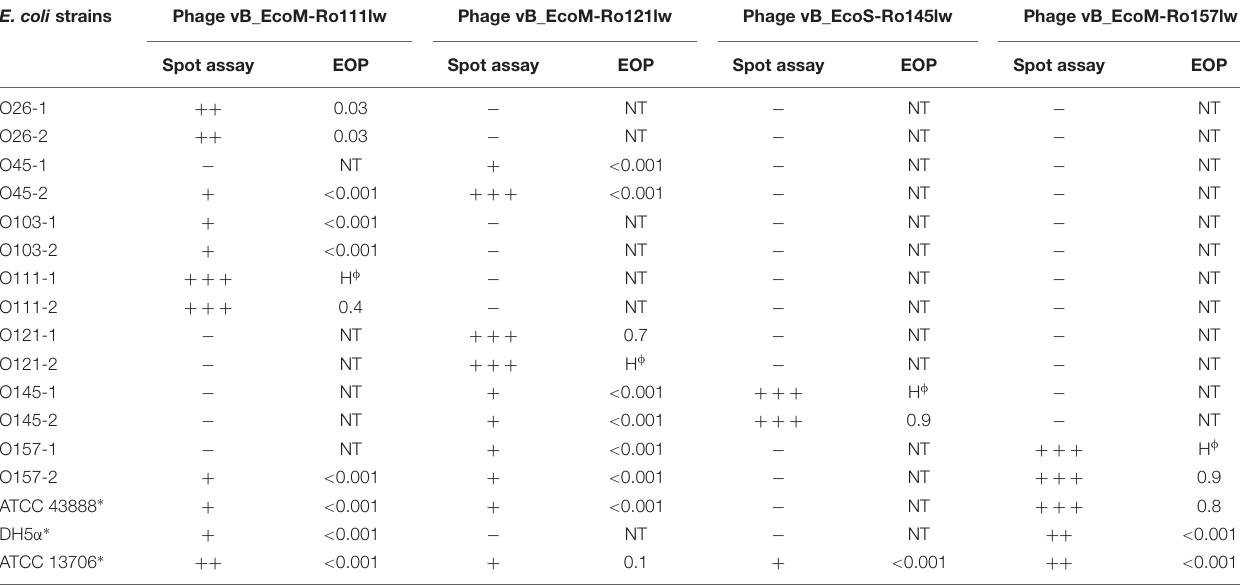
TABLE 2 | Host range and antimicrobial effects of the isolated bacteriophages against various STEC and non-pathogenic strains by spot assay α and EOP β (efficiency of plating).